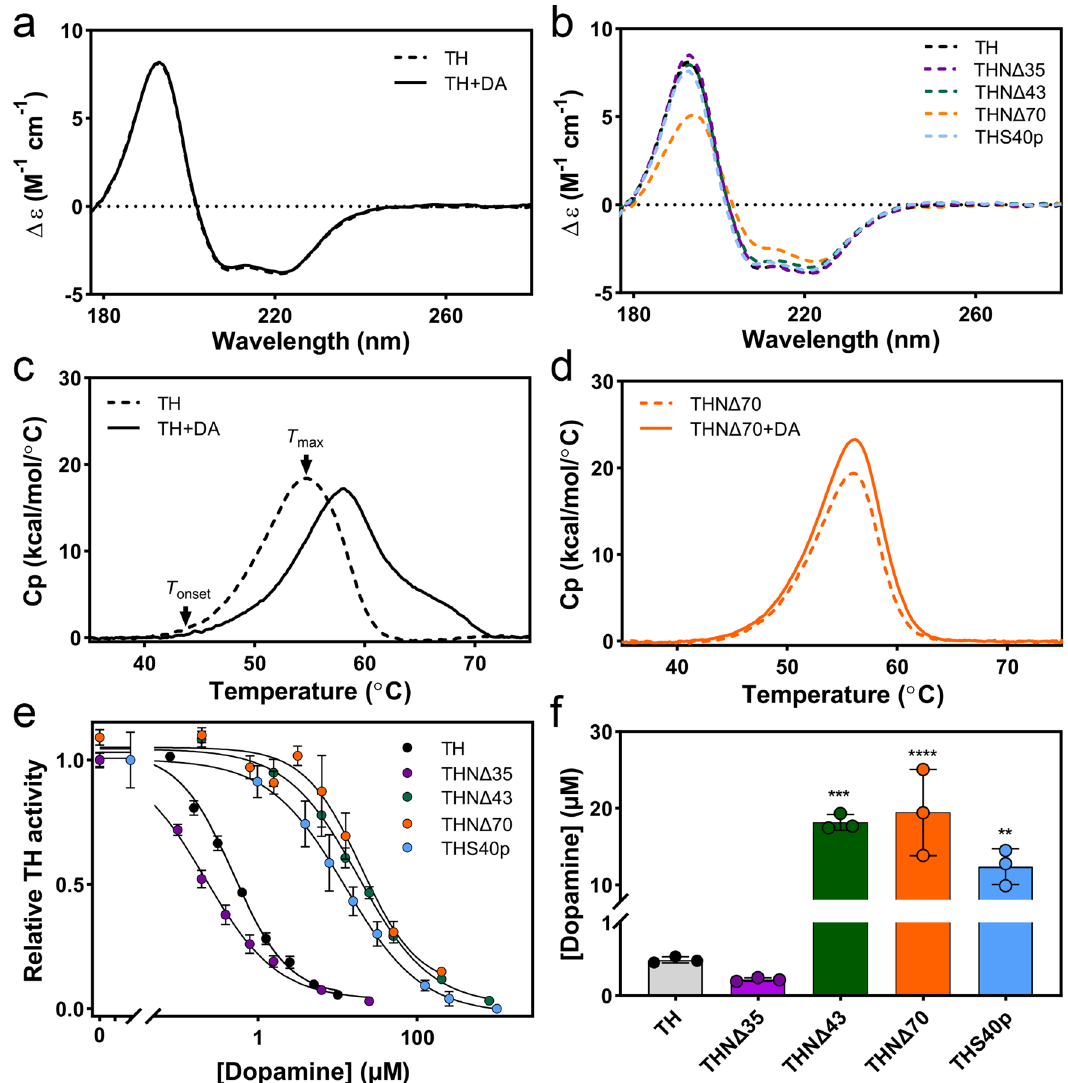
Fig. 5 Biophysical characterization of different TH samples and inhibition of their enzyme activity by DA. Representative synchrotron circular dichroism spectroscopy (SRCD) pro fi les of a apo-TH (broken line) and TH(DA) (continuous line), and b apo-TH (black line), the deletion mutants THN Δ 35 (pink line), THN Δ 43 (green line) and THN Δ 70 (orange line), and TH with phosphorylated S40 (THS40p; blue line). c , d Representative differential scanning calorimetry (DSC) pro fi les, in the absence (broken line) and presence (continuous line) of DA, of TH ( c ) and THN Δ 70 ( d ). T onset and T max are indicated by arrows in ( c ). e Relative TH activity versus DA concentration for apo-TH (black dots), the deletion mutants THN Δ 35 (pink dots), THN Δ 43 (green dots), THN Δ 70 (orange dots), and THS40p (blue dots). Dots represent the mean + SD ( n = 3) and solid lines are fi ttings to the four-parameter logistic nonlinear regression model. f The bars represent the IC50 values obtained from the fi tting the four-parameter logistic nonlinear regression model to triplicate curves, presented as mean ± SD, with the individual values as dots. Asterisks indicate signi fi cant changes compared to TH using one-way ANOVA followed by Tukey ’ s multiple comparisons test; p = 0.0001 (***) for TH vs. THN Δ 43, p > 0.0001 (****) for TH vs. THN Δ 70, p = 0.0026 (**) for TH vs. THS40p. Source data are provided as Source Data